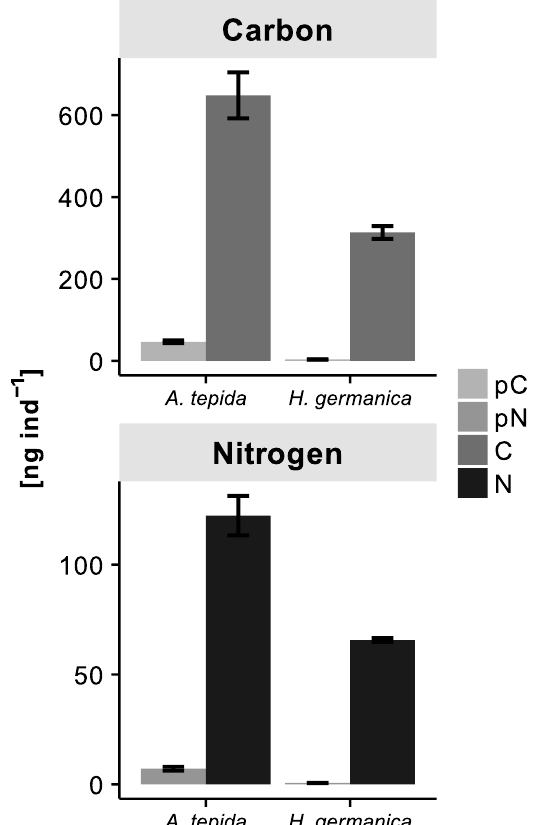
Figure 3. Cytoplasmic carbon (C) and nitrogen (N) content and pC or pN uptake per foraminiferal individual. Data represent values for day 2 of the 20 ◦ C approach. Error bars denote standard deviation.